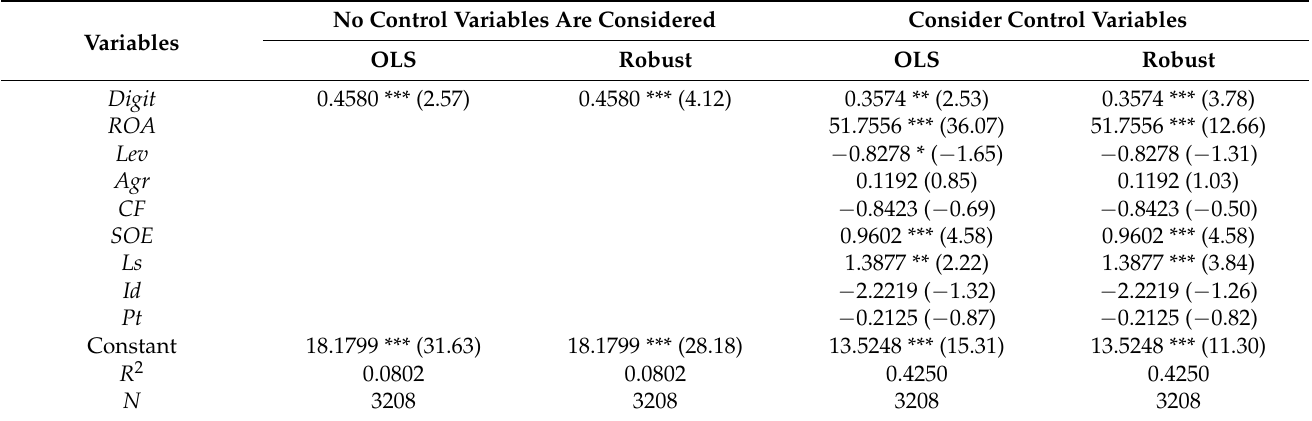
Table 4. Benchmark regression